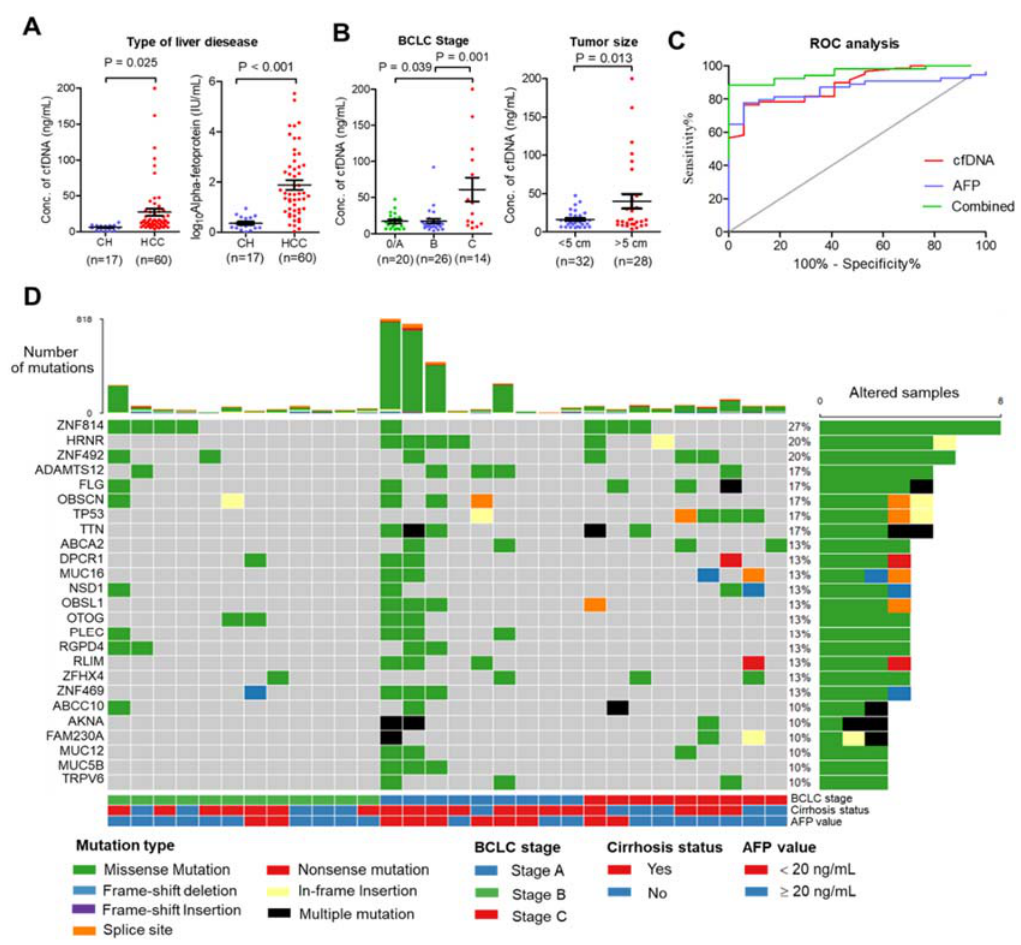
Figure 1. Clinical relationship and landscape of somatic alterations detected in cfDNA from patients with HCC. ( A ) Plasma cfDNA (left) and AFP (right) were significantly higher in HCC patients than in chronic hepatitis patients (CH). ( B ) Relationship of cfDNA and clinical data. Plasma cfDNA was significantly higher in stage C HCC than in stage A or B (left), and plasma cfDNA was higher in HCC patients with tumor size > 5 cm than with tumor size < 5 cm. ( C ) Diagnostic value of cfDNA, serum AFP, and combined cfDNA and AFP. ( D ) Landscape plot of 25 most frequently mutated genes in 30 HCC cfDNA samples. Genes are ordered by mutation frequency, and samples are ordered according to BCLC stage, cirrhosis status, and AFP value as indicated in annotation (bottom). The top bar shows the number of mutations for each sample. The sidebar shows the number of altered samples for each gene.